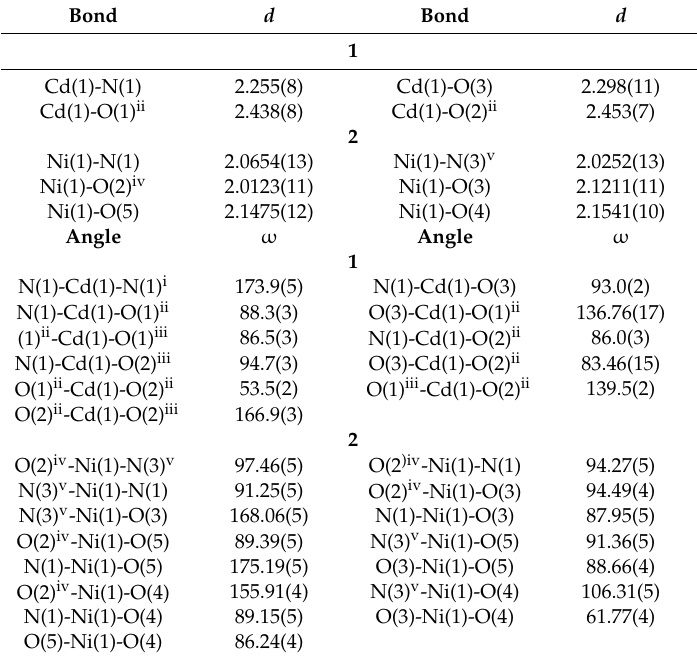
Figure 6. 3D supramolecular network structure of 2 linked by hydrogen bonds and π – π stacking interactions highlighted by pink and blue dotted line, respectively. Table 1. Selected bond lengths (Å) and bond angles (º) for 1 and 2 .